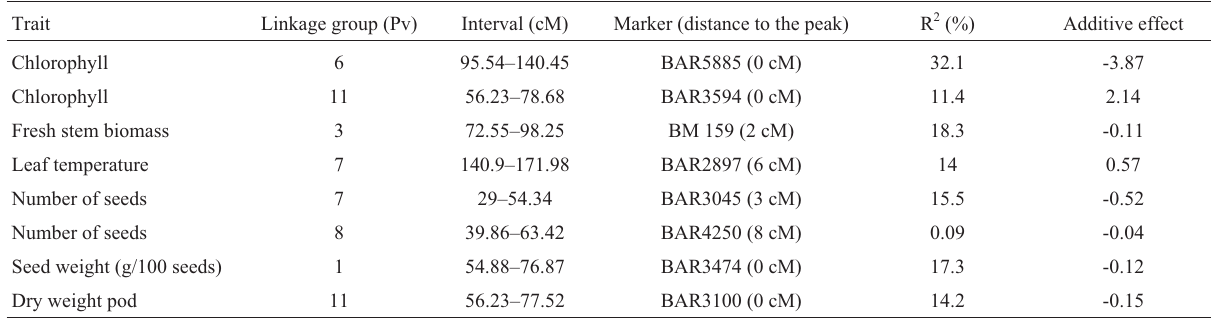
Table 4 - Identification of quantitative trait loci for significant drought tolerance in the AS population, their marker interval, marker located nearest to the QTL peak and its distance from the peak (in